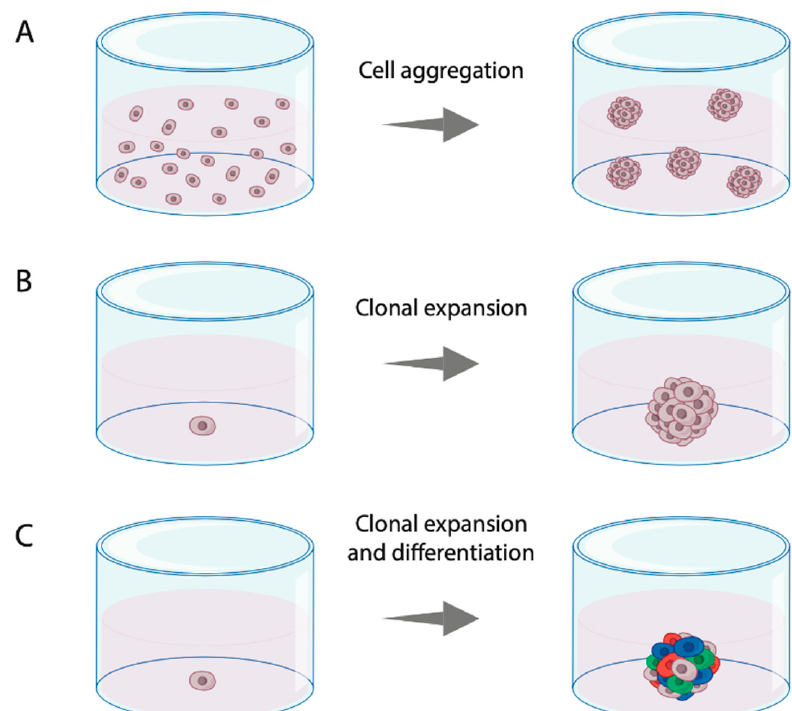
Figure 4. Principles of sphere formation from primary tumor cells. ( A ) Sphere formed by aggregation of multiple cells in a single-cell suspension; ( B ) sphere formed by clonal expansion of a single cell with proliferating potential; ( C ) sphere formed by clonal expansion and lineage-dependent differentiation of a single cell with proliferating potential.